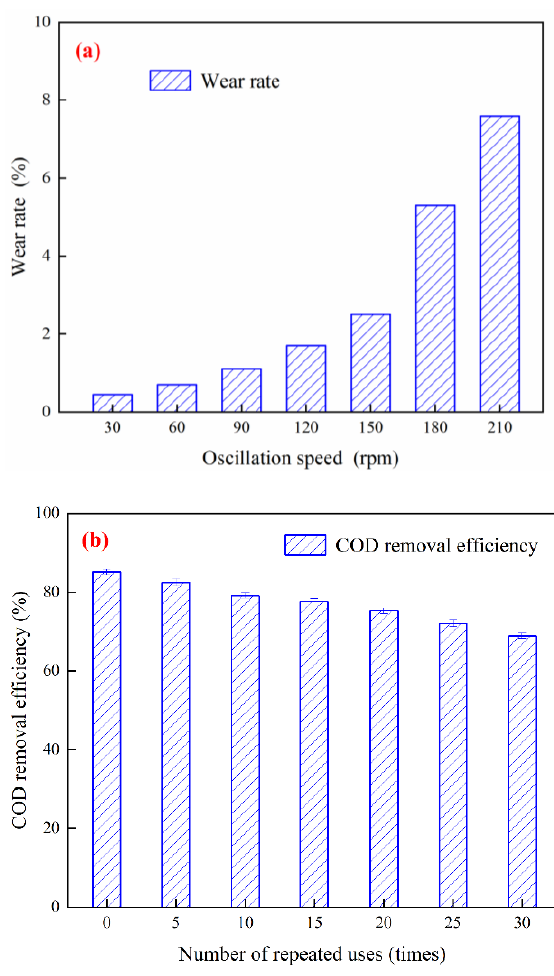
Figure 10. Catalyst stability ( a ) wear resistance analysis of Cu- Ce@γ -Al 2 O 3 catalyst, ( b ) effect of repeated use on COD removal efficiency.